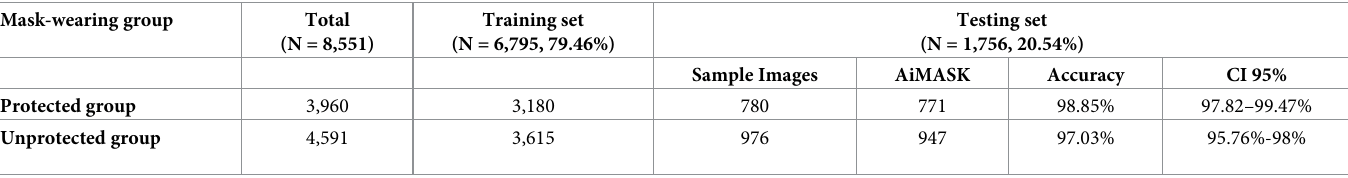
Table 1. Overall performance of AiMASK on training and testing datasets. Mask-wearing